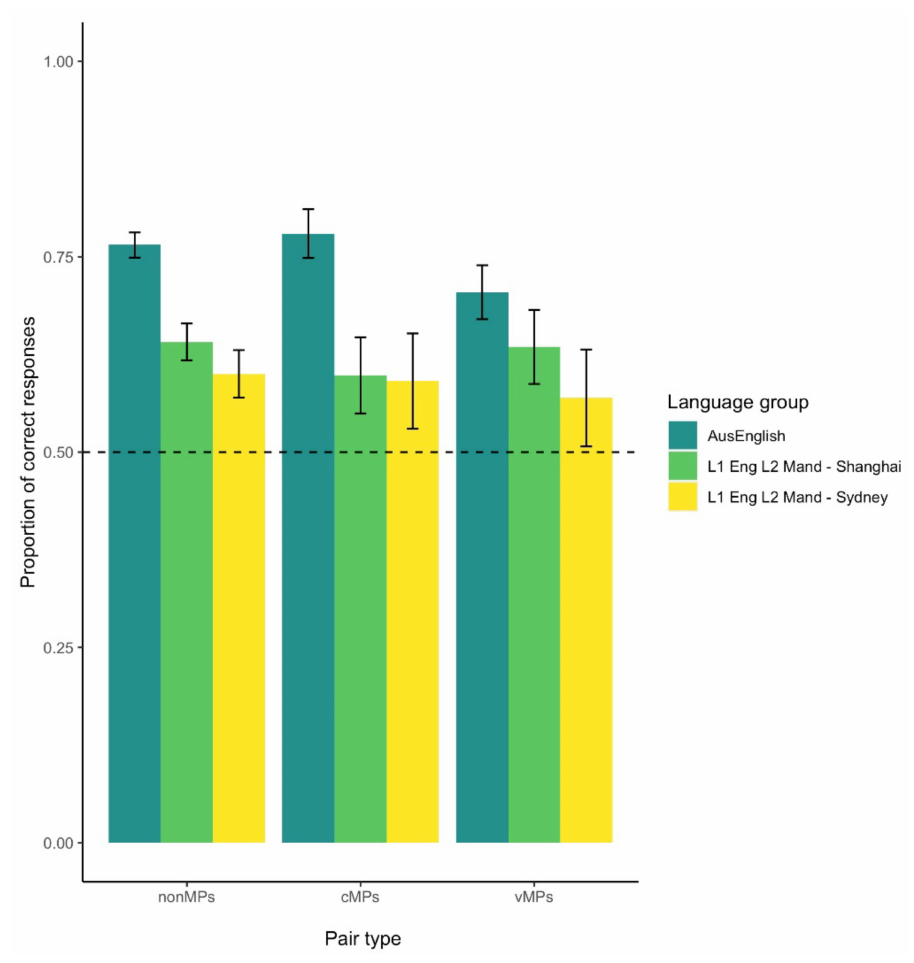
Figure 3. Mean accuracy in percentage per language group and pair type. Error bars indicate the standard error of the